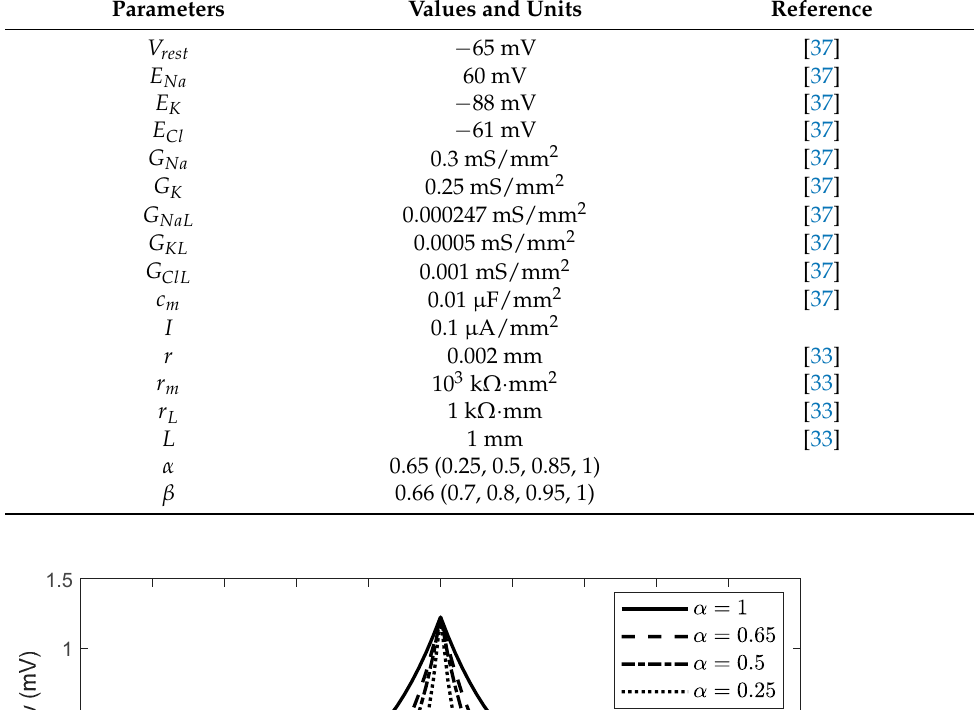
Table 1. List of parameters with corresponding values and physical units. Parameters Values and Units Reference